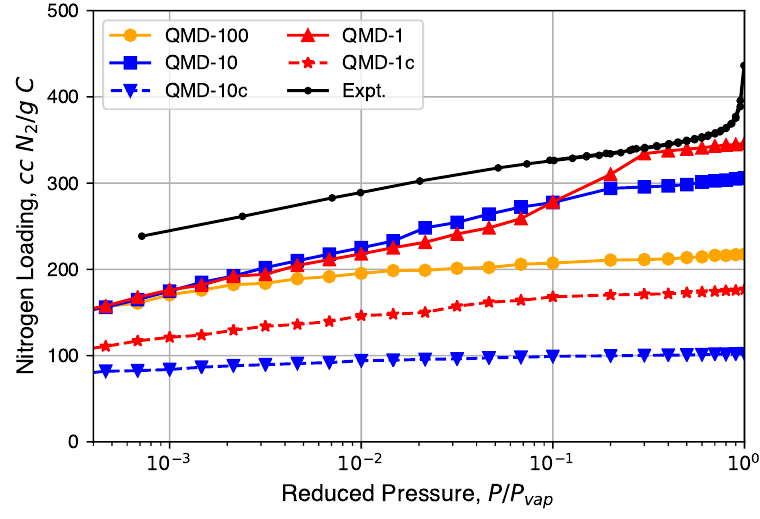
Figure 6. Nitrogen isotherms generated from grand canonical Monte Carlo (GCMC) simulation in comparison to experimental